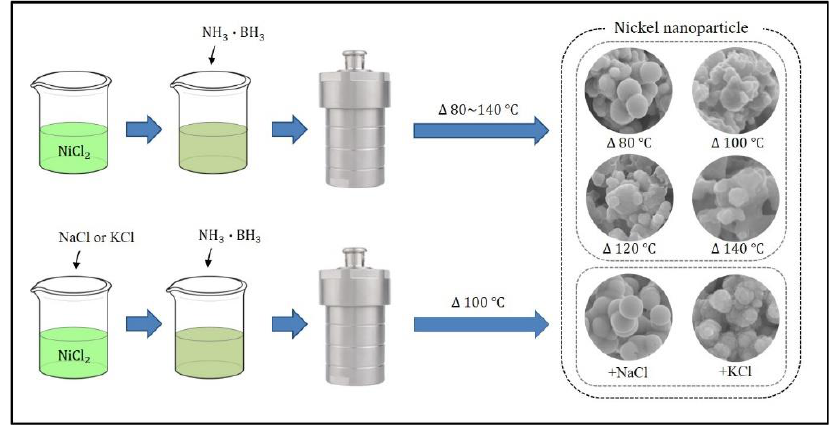
Scheme 1. Scheme of synthetic steps of one-pot-synthesized Ni nanoparticles.